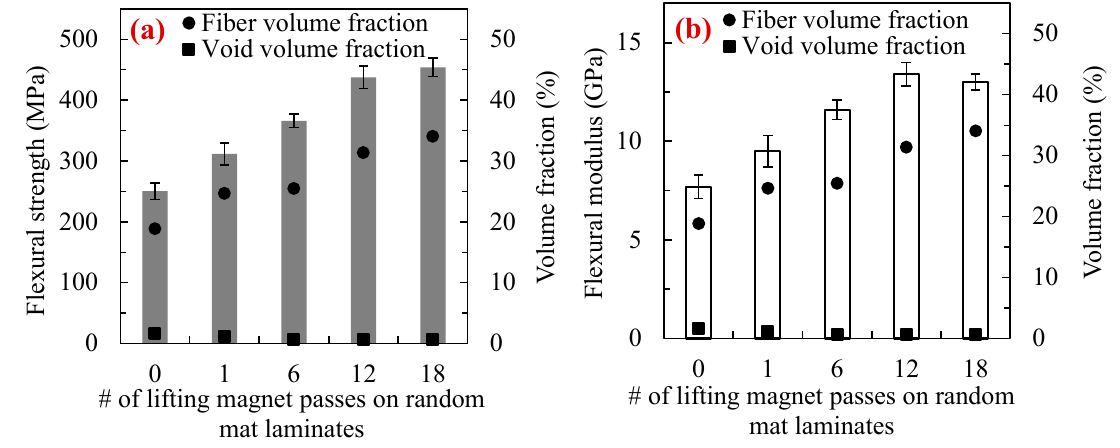
Figure 9. ( a ) Flexural strength and ( b ) modulus of random mat laminates fabricated with WLVB and increasing number of passes of a lifting magnet (i.e., 0, 1, 6, 12, and 18 passes). Void and fiber volume fraction values are also presented. Note: Error bars show the 95% confidence interval ( n = 14 samples).